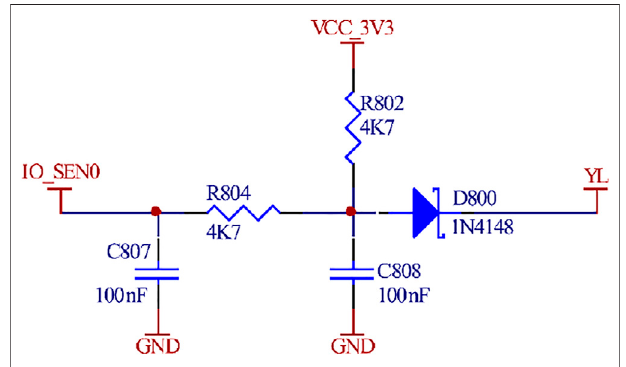
FIGURE 5 | Circuit schematic diagram of rainfall data collection sensor.